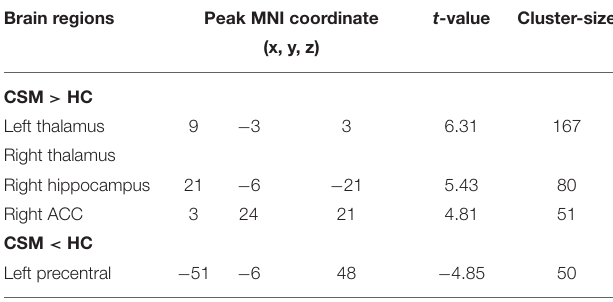
TABLE 2 | Difference in voxel-wise FCS between CSM patients and healthy individuals.